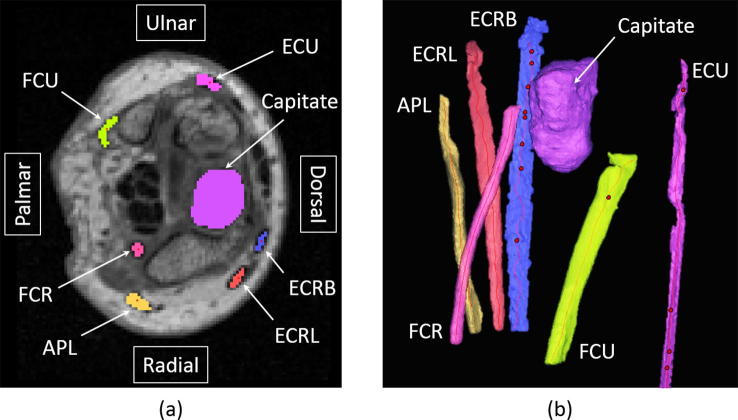
The capitate and tendons of the wrist, with centrelines, as seen in (a) a transverse section of a magnetic resonance imaging (MRI) scan and (b) 3D reconstructions from the MRI scan. Moment arms of the tendons of the flexor carpi radialis (FCR), flexor carpi ulnaris (FCU), extensor carpi radialis longus (ECRL), extensor carpi radialis brevis (ECRB), extensor carpi ulnaris (ECU), abductor pollicis longus (APL) were quantified.